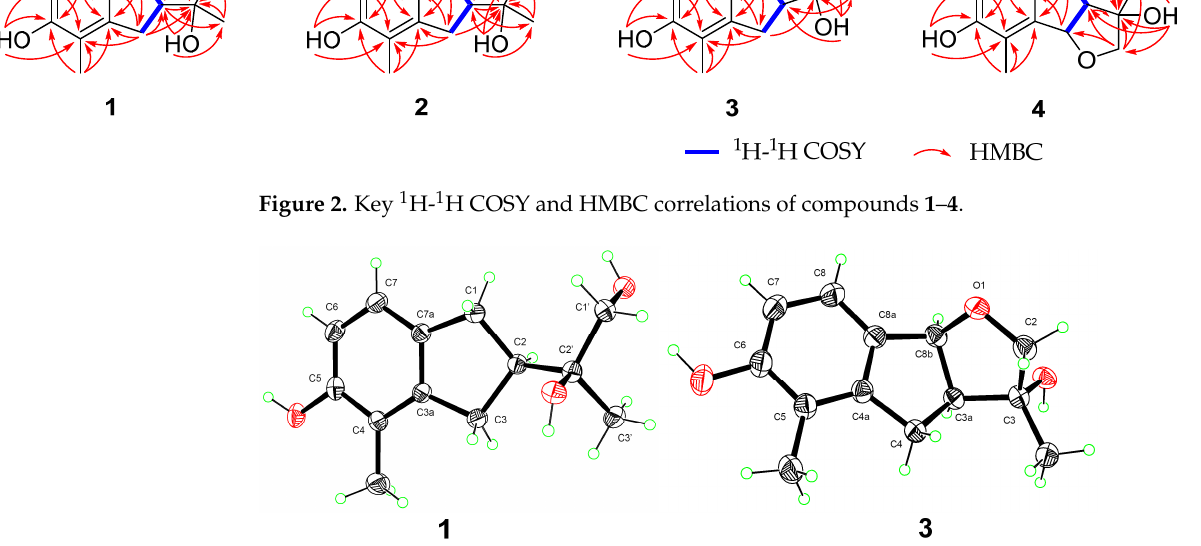
Figure 3. X-ray crystallographic structures of compounds 1 and 3 .